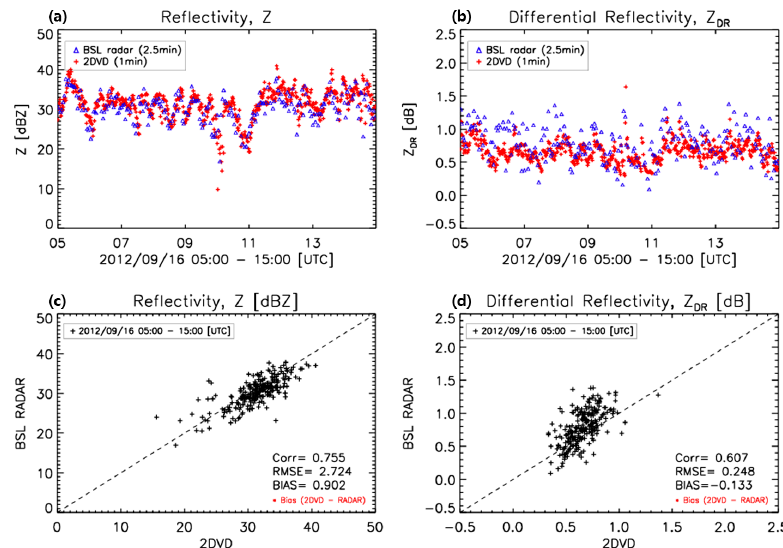
Figure 10. Same as Fig. 9, except that the data are for 16 September